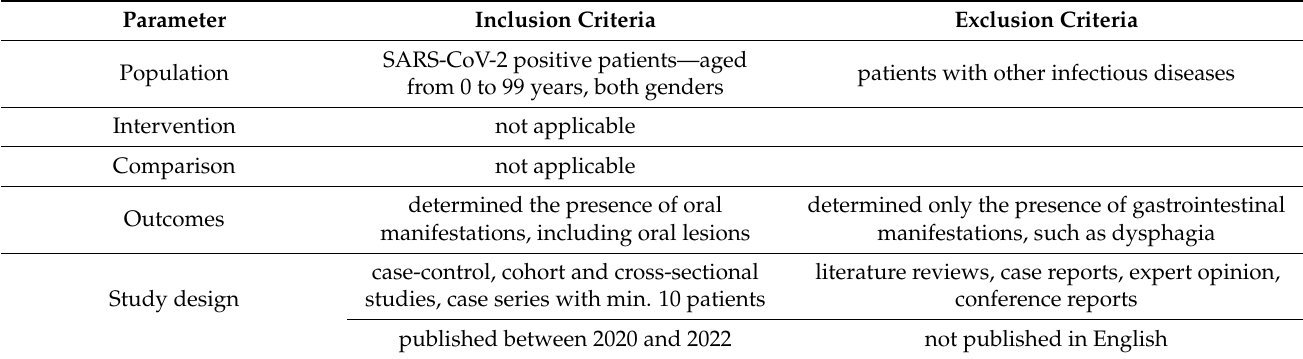
Table 1. Inclusion and exclusion criteria according to the